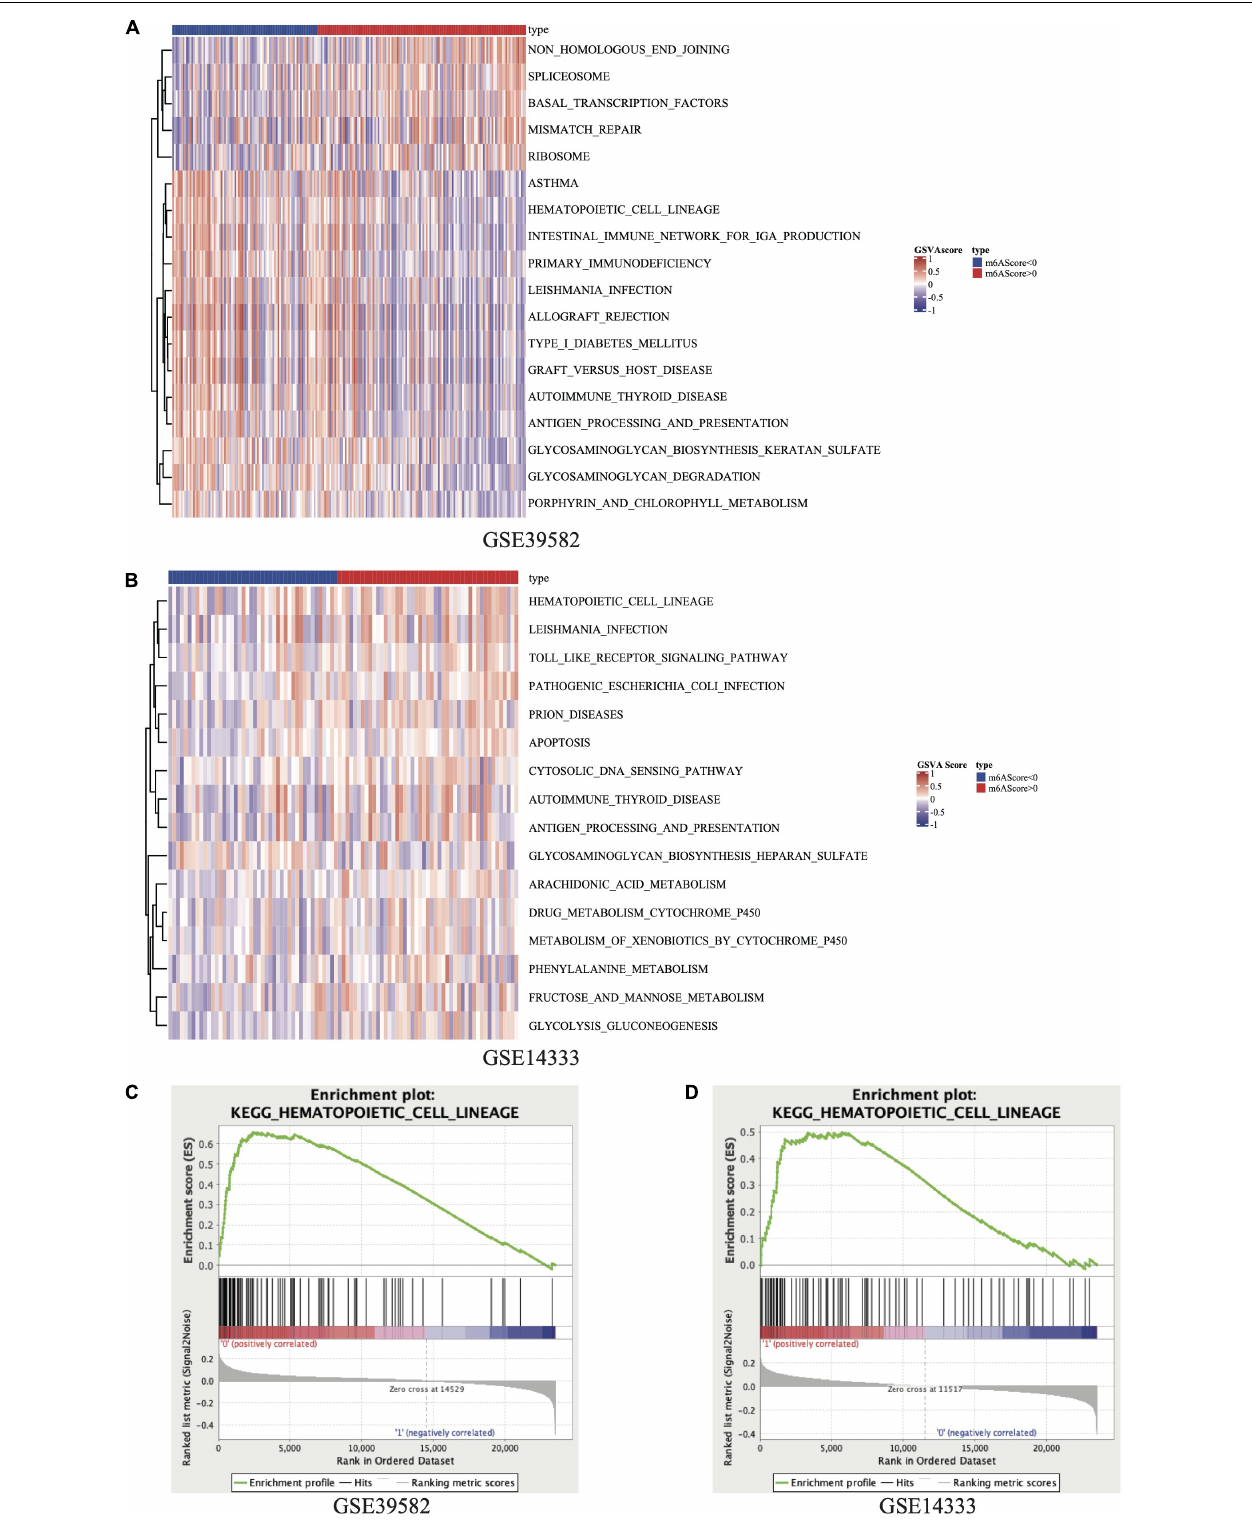
FIGURE 2 | Heatmap of GSVA results in GSE39582 (A) and GSE14333 (B) . Results of GSEA on KEGG_HEMATOPOIETIC_CELL_LINEAGE pathway in GSE39582 (C) and GSE14333 (D) .